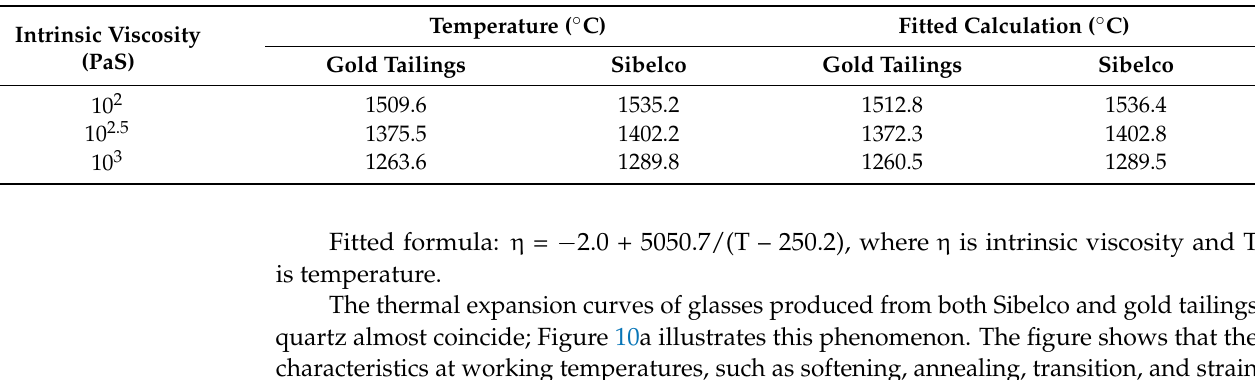
Table 14. Corresponding temperature–viscosity values for gold tailings and Sibelco